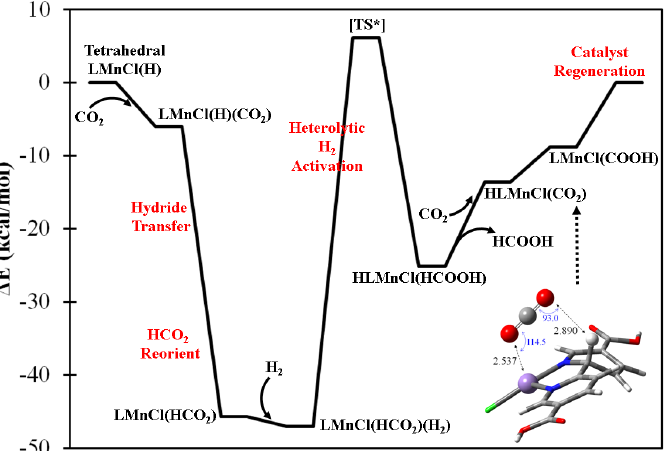
Figure 4. The predicted catalytic mechanism of formic acid generation by high-spin (s = 5/2) (bpydc)MnCl(H) complex with H 2 (g) + CO 2 (g). [TS*] denotes the approximate transition state.